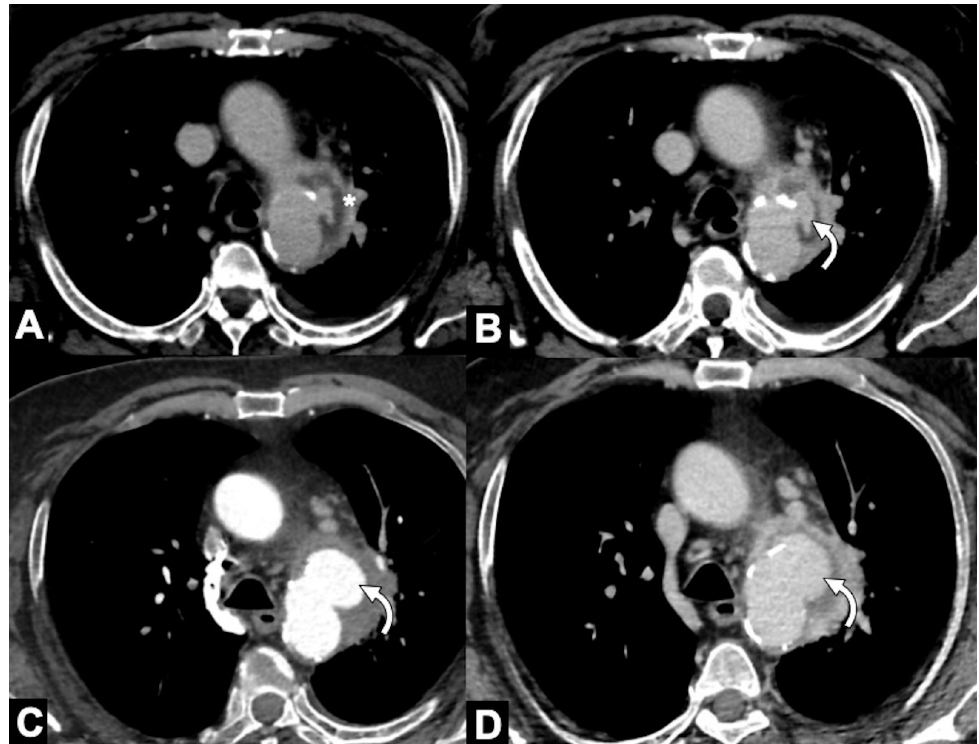
Figure 14. CTA of aortitis and periaortitis by Salmonella species. A 68-year-old man with chills, high temperature, and upper back pain radiating to anterior chest. ( A ) Unenhanced CTA axial image shows marginal periaortic tissue (asterisk) at aortic isthmus level. ( B ) Axial CTA late phase image also shows a focal outpouching (curved arrow) of contrast material emanating from the isthmus. ( C , D ) Axial arterial and delayed-phase CTA images obtained 7 days later show that contrast outpouching was considerably larger (curved arrows), a finding referable to rapidly growing focal mycotic pseudoaneurysm, and the patient underwent endovascular aortic repair and intravenous antibiotic therapy.